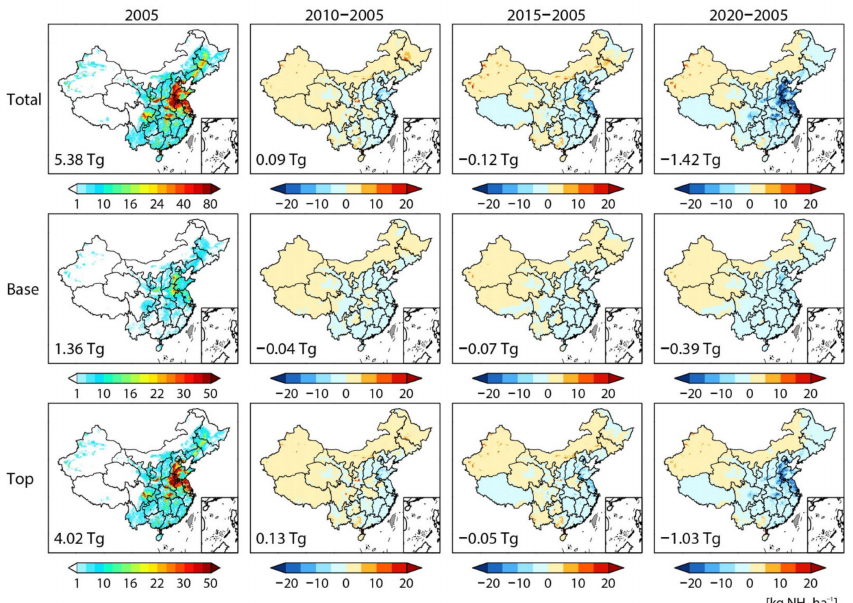
Figure 3. Spatial distribution of synthetic nitrogen fertilizer application in 2005 (first column) and changes in 2010, 2015 and 2020 (second, third and fourth column) compared to 2005 over China in total (first row), basal dressing (at planting, typically through injection, second row) and top dressing (at growth, typically through broadcast, third row), the national total values of the plot are embedded in the left corner. The numbers in the first column represent the total nitrogen fertilizer application in 2005, and the numbers in the second to the fourth column represent the total change in that year compared with 2005.